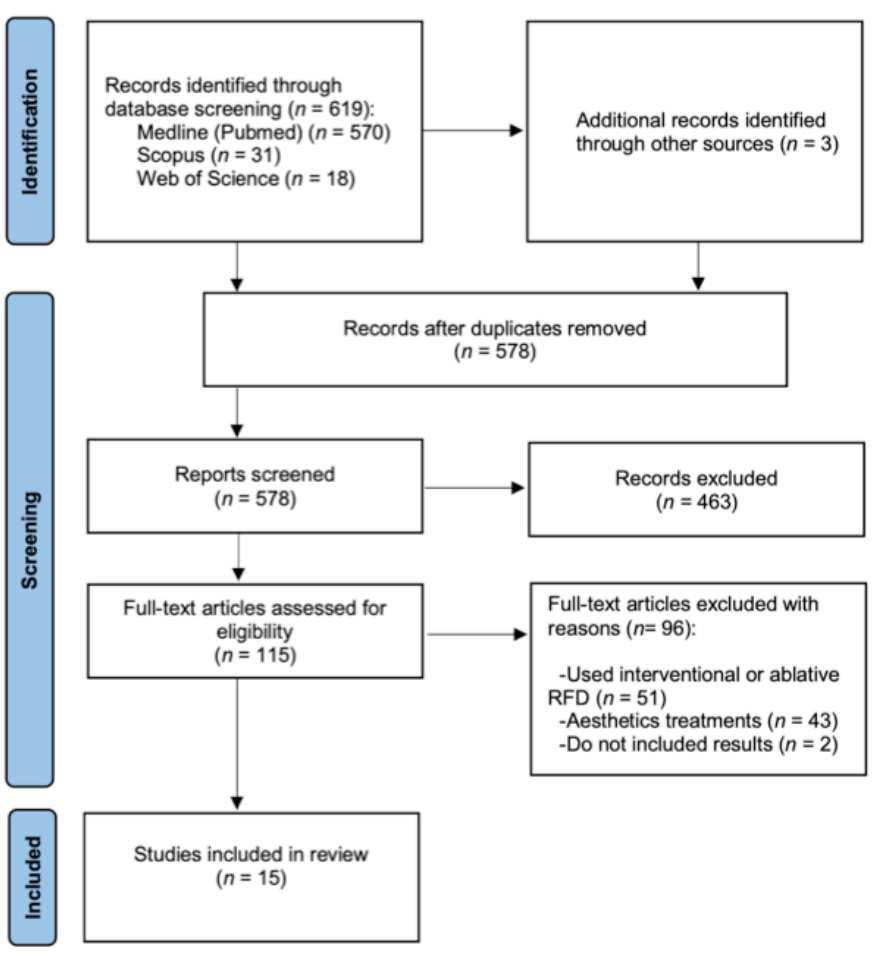
Figure 1. Flow diagram of the study search.